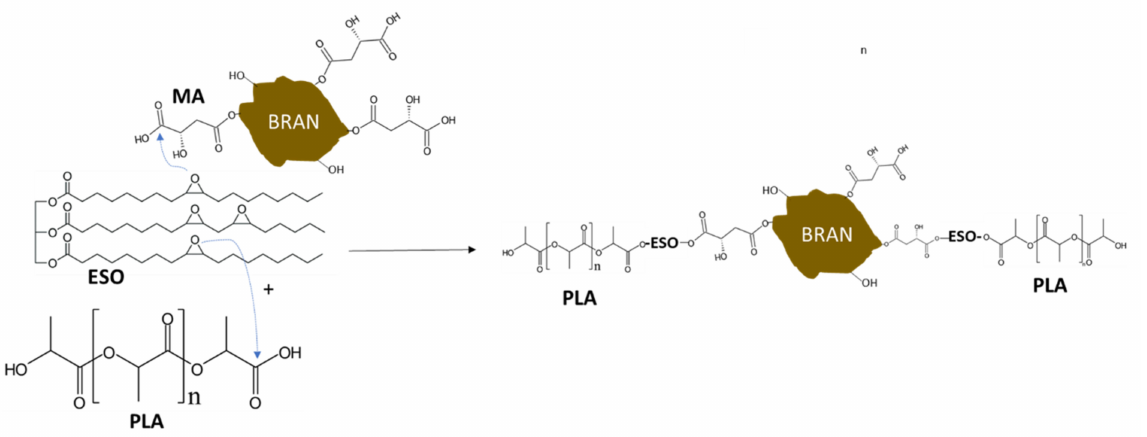
Figure 13. Reactions pattern between a bran particle, biopolyesters, MA, and